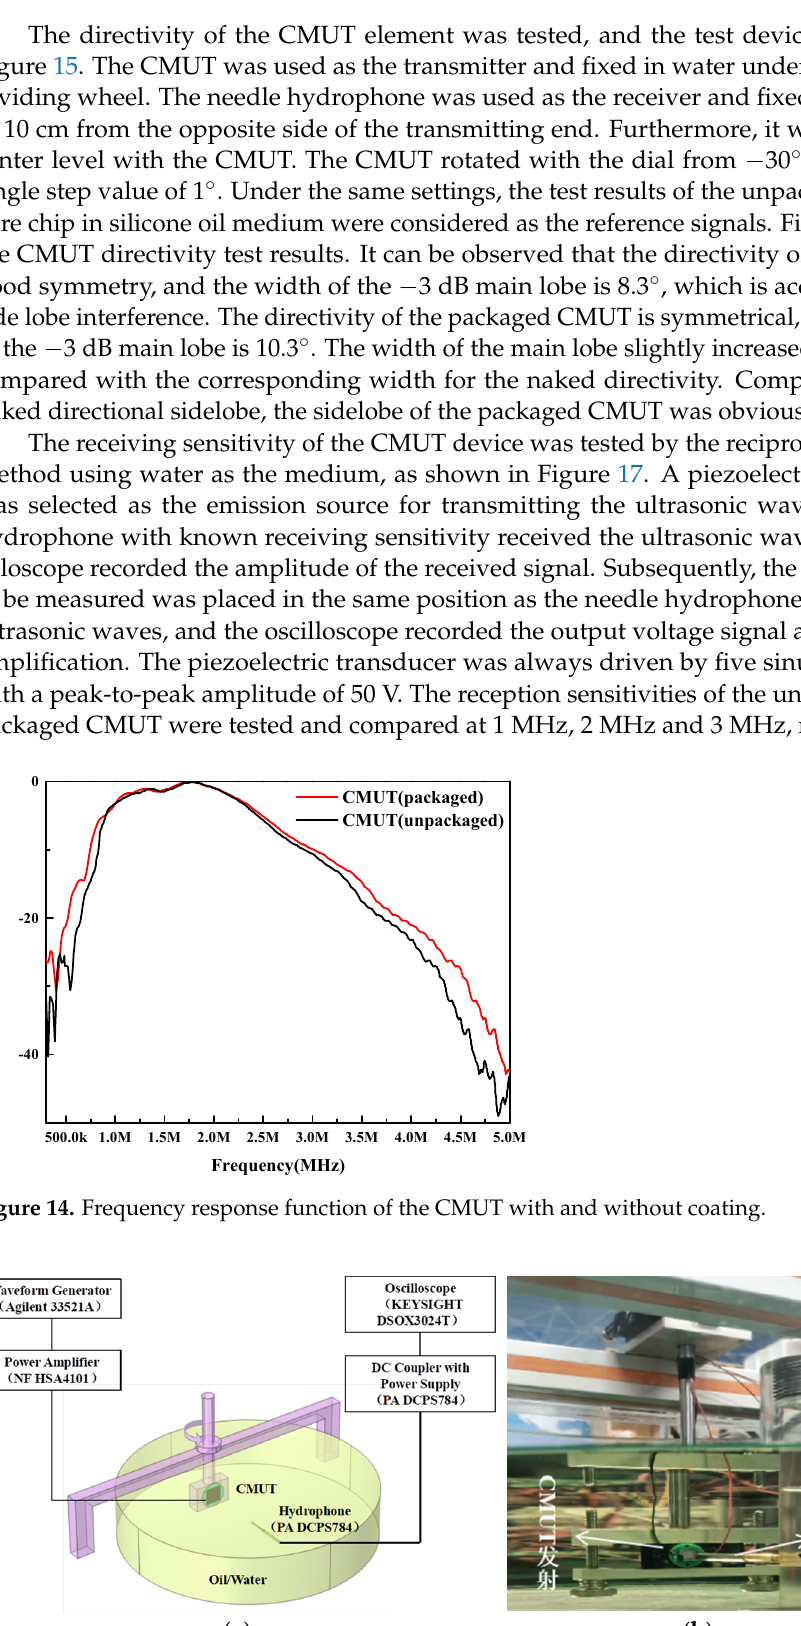
Figure 16. Transmitting directivity of the CMUT with and without coating. The receiving sensitivity of the CMUT device was tested by the reciprocal calibration method using water as the medium, as shown in Figure 17. A piezoelectric transducer was selected as the emission source for transmitting the ultrasonic waves. A needle hydro- phone with known receiving sensitivity received the ultrasonic waves, and an oscillo- scope recorded the amplitude of the received signal. Subsequently, the CMUT device to be measured was placed in the same position as the needle hydrophone to receive the ultrasonic waves, and the oscilloscope recorded the output voltage signal after low noise amplification. The piezoelectric transducer was always driven by five sinusoidal pulses with a peak-to-peak amplitude of 50 V. The reception sensitivities of the unpackaged and packaged CMUT were tested and compared at 1 MHz, 2 MHz and 3 MHz, respectively. -30